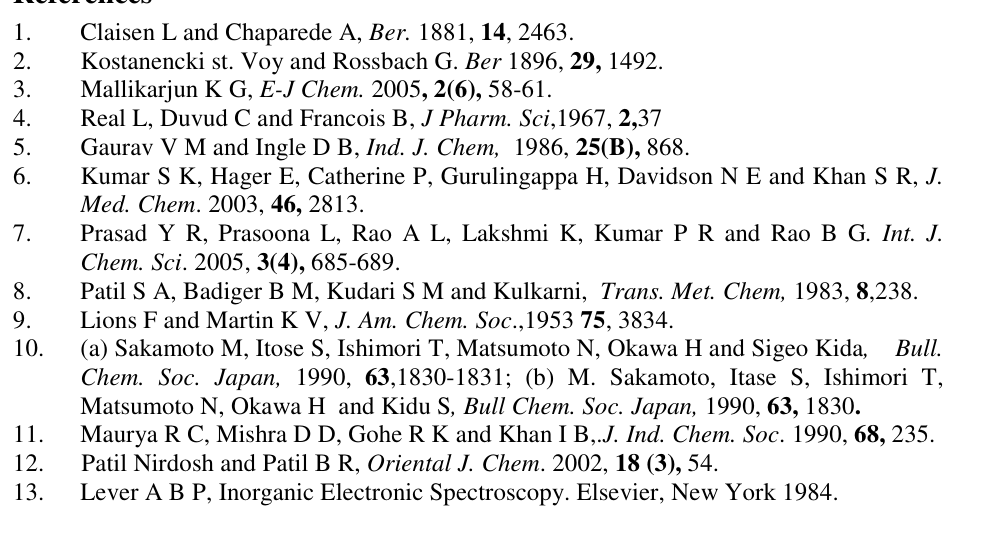
Streptomycin Chlorometazole Bore